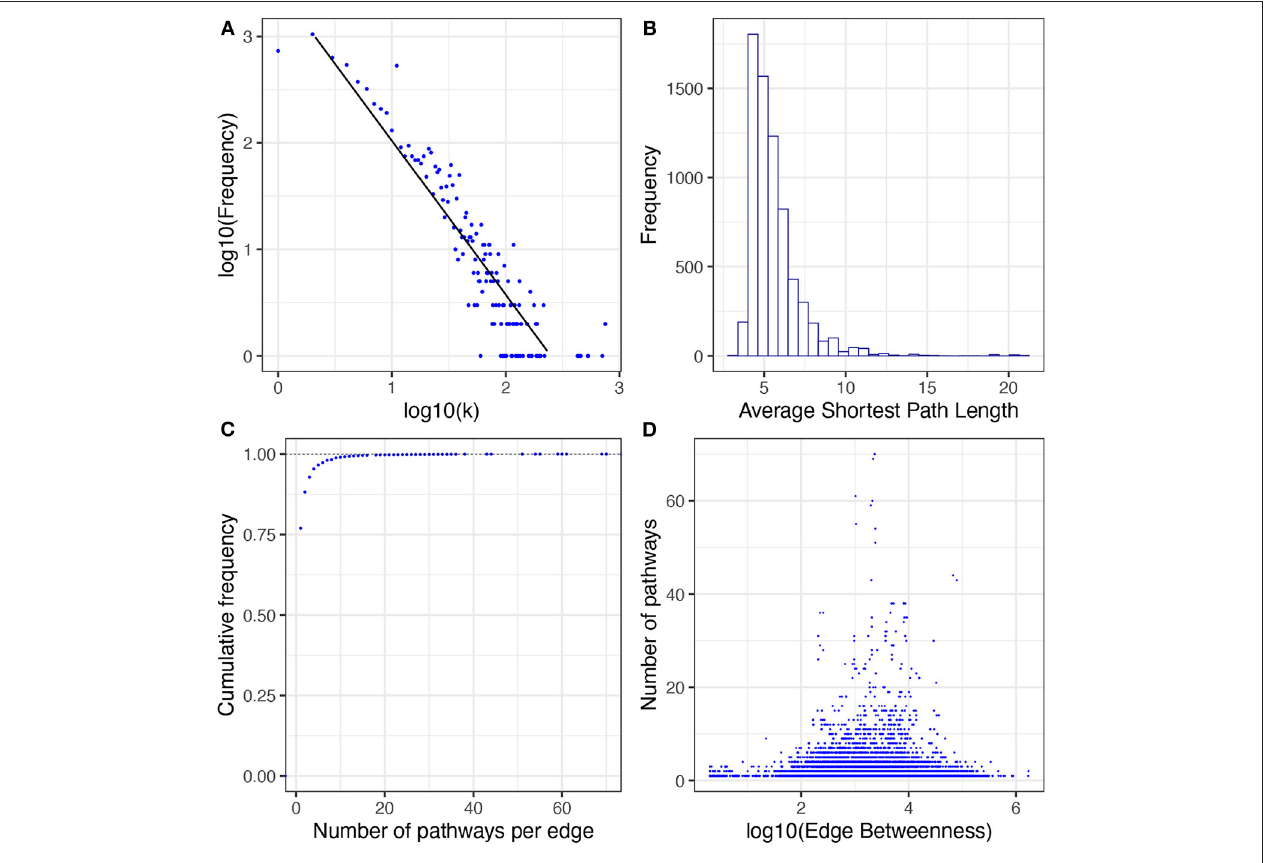
FIGURE 7 | Topological and structural features of the GCC. (A) presents the degree distribution. (B) presents the average shortest path length distribution. (C) presents the cumulative distribution of pathways per edge. (D) presents the correlation between number of pathways and edge betweenness; a dot for each edge of the GCC is plotted. The x-axis corresponds to its value of edge betweenness and the y-axis corresponds to the number of pathways in which that interaction exists. No correlation patterns are apparent [ ρ = − 0.09, p − value < 2.2 E ( −